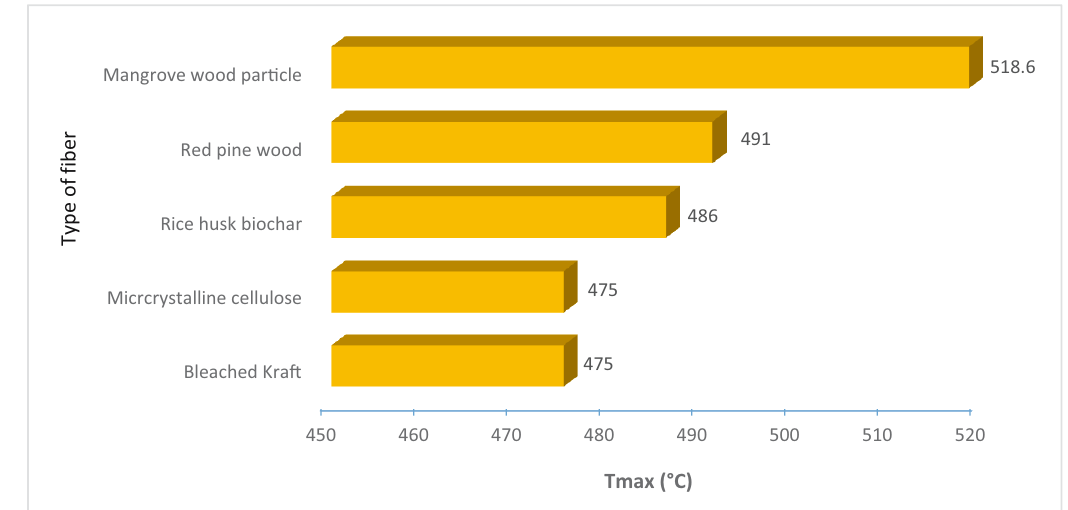
Figure 3: T max values of HDPE composites at 30 wt% of di ff erent types of fi